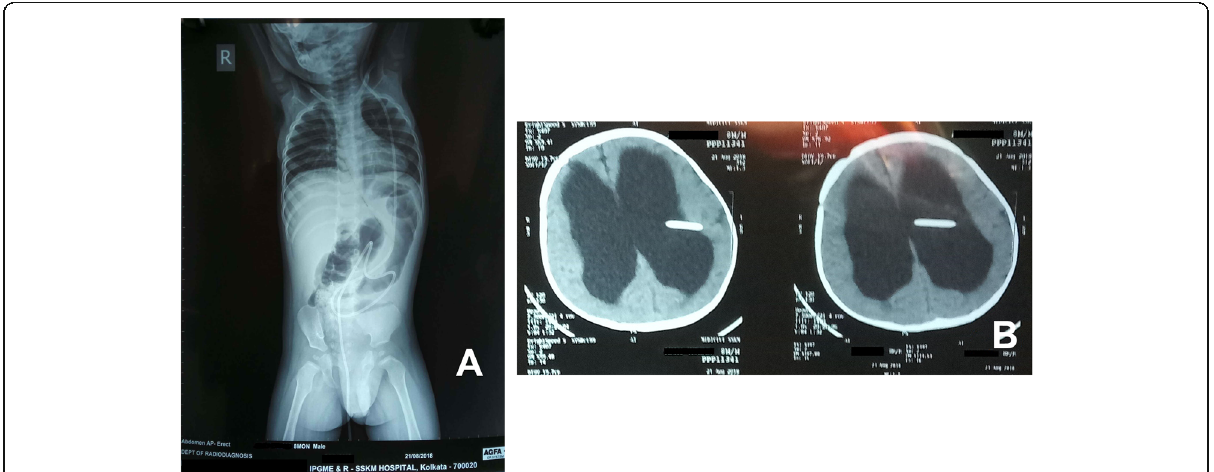
Fig. 2 a Digital X-ray of whole abdomen postero-anterior view in erect posture shows expulsion of radio-opaque distal catheter tip through the anus into the exterior without any pneumoperitoneum. b NCCT scan shows the cranial catheter tip in the lateral ventricle of the